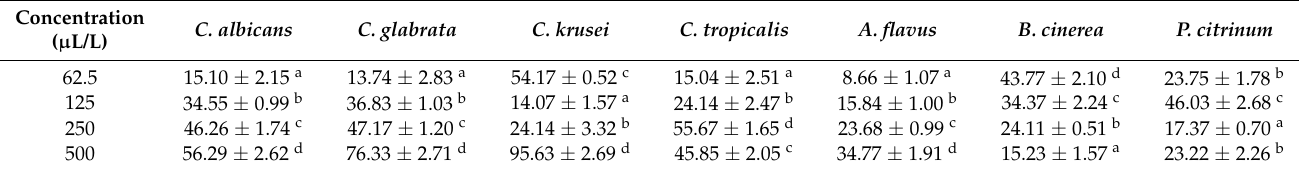
Table 8. Microscopic filamentous fungi growth inhibition after FEO addition